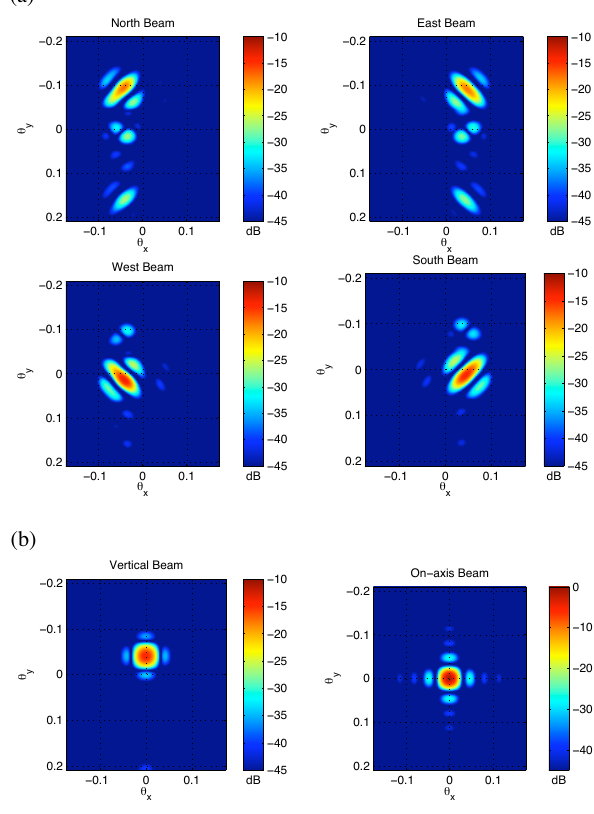
Table 1. Experiment parameters used at Jicamarca in May 2003 and July 2004. Range and gap parameters are in km units and the fifth column gives the number of sampled range gates. The “gap” refers to upper stratospheric heights from which no detectable radio returns are expected. The average spectrum from these heights is regarded as the estimate of the background noise spectrum and is referred to in the text as B(ω) .